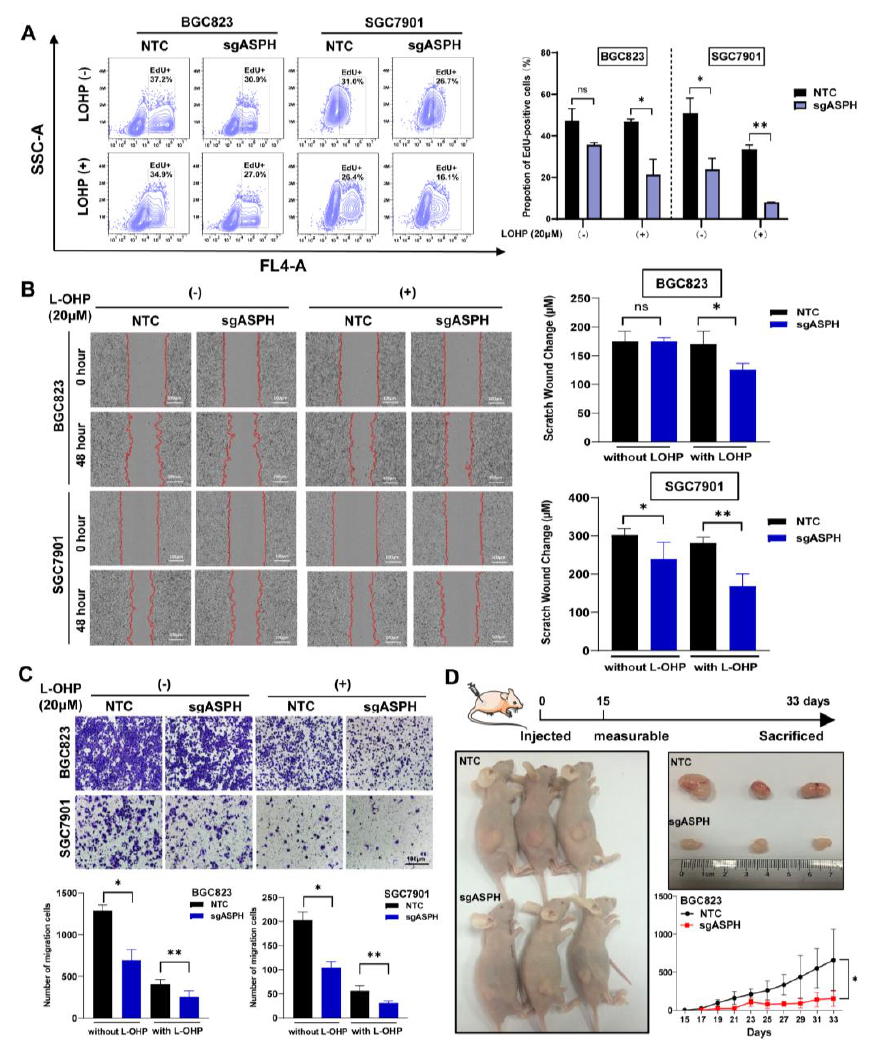
Figure 2. Effects of ASPH knockout on oncogenic capacity of human GC cells. ( A ) GC cell prolif- eration was detected by means of the EdU assay. ( B , C ) Knockout ASPH reduced cell migration, as observed by wound-healing and trans-well assays, especially when cells were administered L-OHP. Scale bar: 100 μ m . ( D ) ASPH knockout cells inhibited tumorigenicity. Tumor growth curves were measured every 2 days. All data indicate the mean ± SD. ns p > 0.05, * p < 0.05, ** p < 0.01.